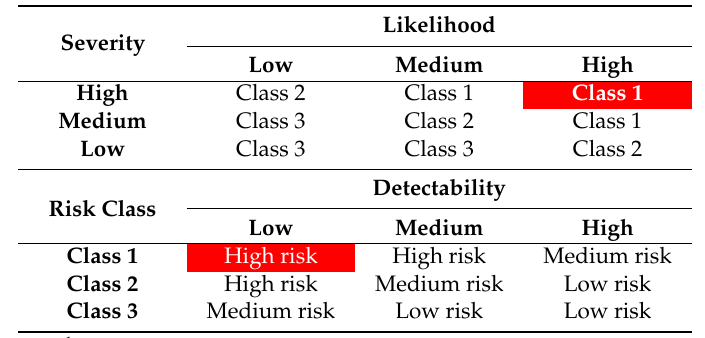
Table 2. PERV Risk Assessment based on scientific knowledge in mid-1990s 1 .